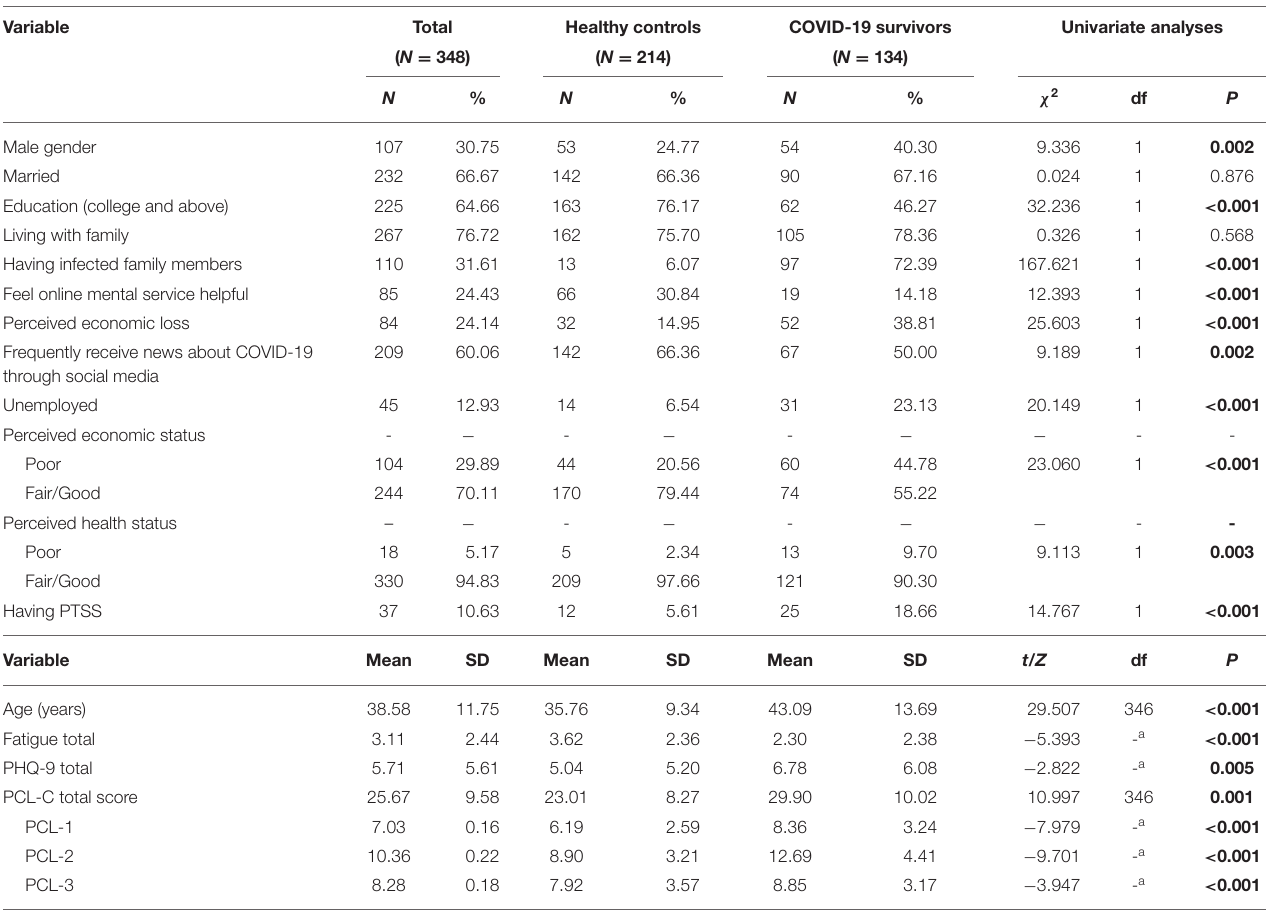
TABLE 1 | Socio-demographical and clinical characteristics of the participants.